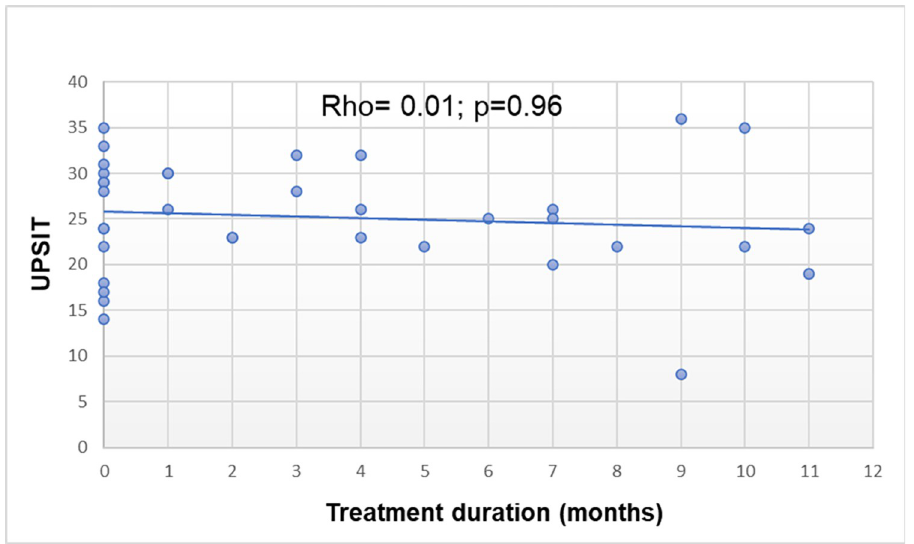
Fig 1. Correlation between UPSIT and treatment duration in months. Rho: Spearman´s correlation coefficient.